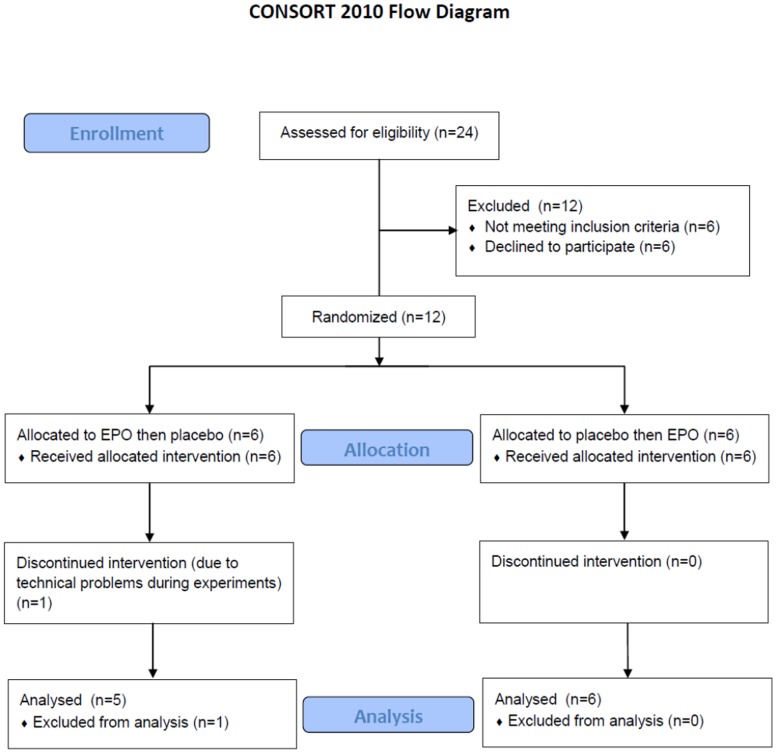
The Consort diagram.